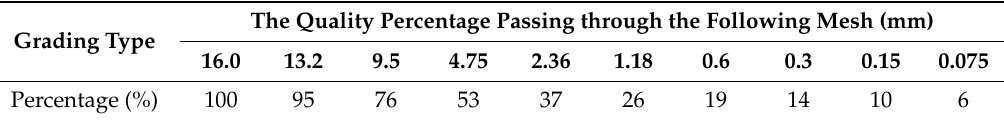
Table 3. Asphalt mixture synthesis grading calculation table.